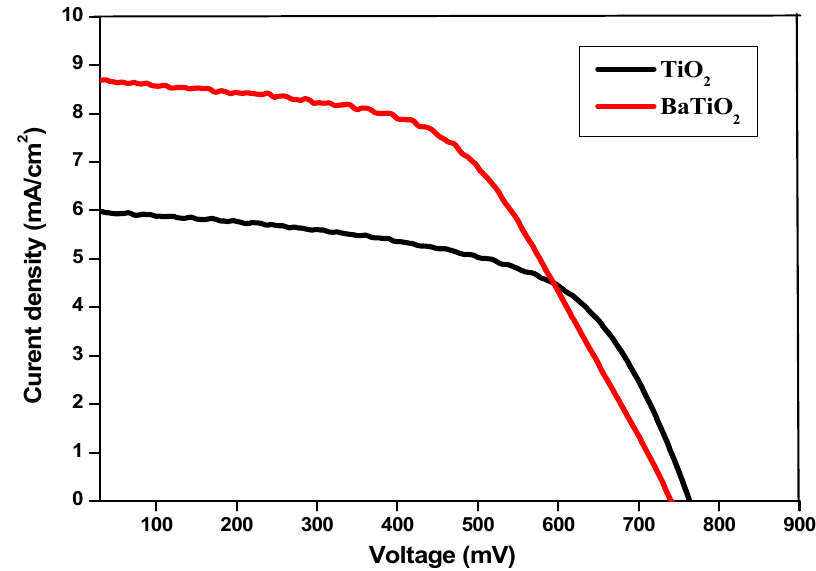
Figure 7. Photovoltaic response of synthesized TiO 2 and Ba/TiO 2 photoanodes. The Ba/TiO 2 photoanode yielded higher PCE (3.4%) compared to the TiO 2 pho- toanode (2.1%). The calculated photovoltaic parameters are summarized in Table 3. The higher PCE of the Ba/TiO 2 photoanode (3.4%) corresponds to a maximum output power density (P max ) of approximately 34.4 μ W/cm 2 as compared to the TiO 2 photoanode’s P max of 26.5 μ W/cm 2 . These findings suggest that DSSCs can be produced with the appropriate power rating to operate electronic devices such as tablets and Internet-of-Things gadgets that require low power P max < 100 μ W/cm 2 [56]. Table 3. Photovoltaic parameters derived from current voltage characteristic curves of synthesized TiO 2 and Ba/TiO 2 photoanodes. Sample Short Circuit Current Den- sity J sc (mA/cm 2 ) Open Circuit Voltage V oc (mV)